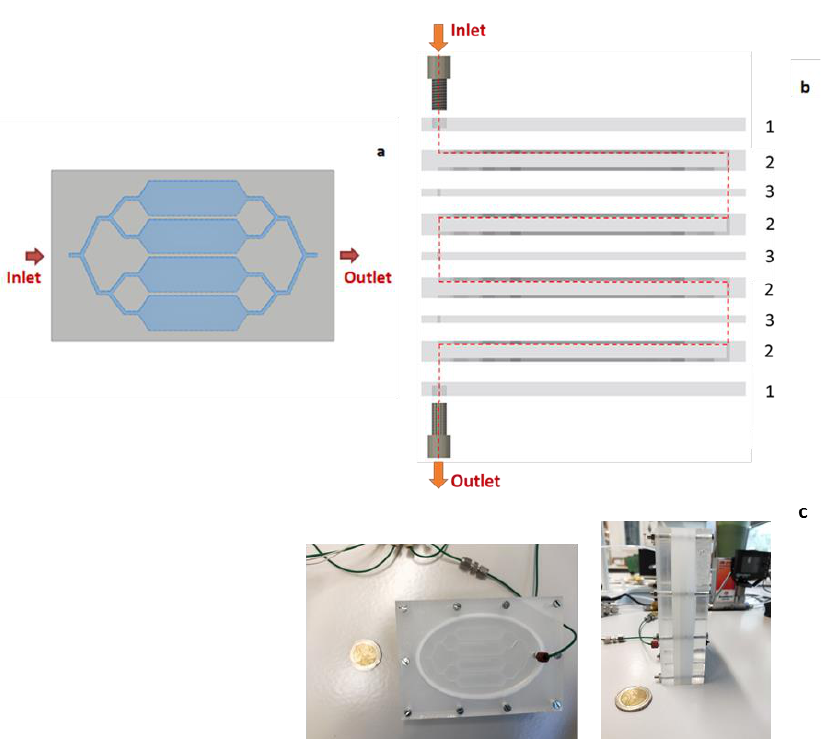
Figure 3. Schematic drawing of ( a ) the design of a 4 buffer stage as numerically studied by Noel et al. (2019) [36] for which dimensions can be found in Figure S3A; ( b ) image of a 4-stage micromixer [36] comprising four mixing plates milled on one side with a four buffer tanks (2), one inlet and outlet plate (1) as well as one connection plate (3) to link two mixing plates; ( c ) photographs of the 4-stage micromixer prototype manufactured and tested in this work.